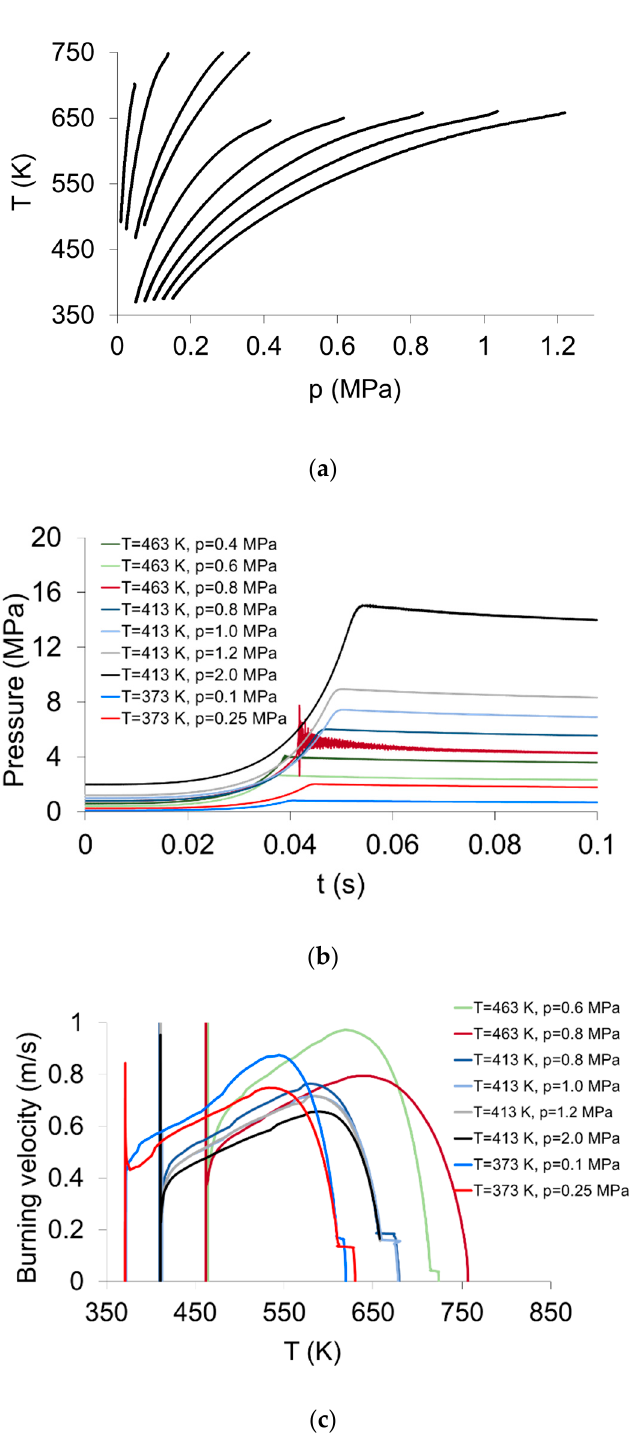
Figure 8. ( a ) Pressure–temperature diagram; ( b ) pressure; ( c ) burning velocity. The temporal evolution of the pressure and burning velocity of n-heptane versus the unburned temperature for stoichiometric combustions.